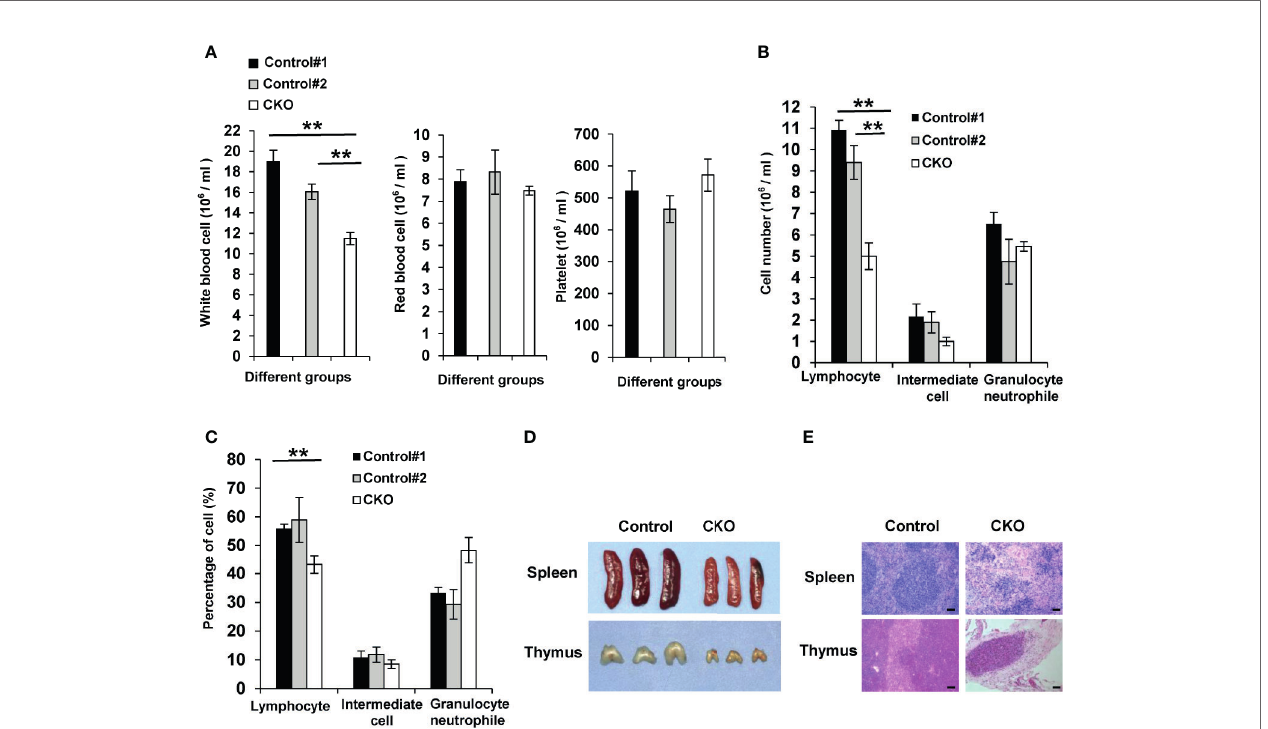
FIGURE 3 | eIF4B de fi ciency results in a signi fi cant decrease of immune cells. (A) The number of blood cells from the peripheral blood of eIF4B CKO mice and control littermates was counted using an automatic blood cell analyzer (n = 7-10). Data are represented as mean ± SD. **p ≤ 0.01. (B, C) The number (B) and percentage (C) of different types of WBC (lymphocytes, intermediate cells and granulocyte neutrophils) of eIF4B CKO mice and control littermates were analyzed by complete blood cell counting (n = 7-10). Data are represented as mean ± SD. **p ≤ 0.01. (D, E) Representative images of spleen and thymus (D) and tissue sections (E) of eIF4B CKOmice and control littermates. Scale bars, 100 µm. “ Control#1 ” represents “ eIF4B f/f , Cre + Cornoil ” group, “ Control#2 ” represents “ eIF4B f/f + Tamoxifen ” group, “ CKO ” represents “ eIF4B f/f , Cre + Tamoxifen ”